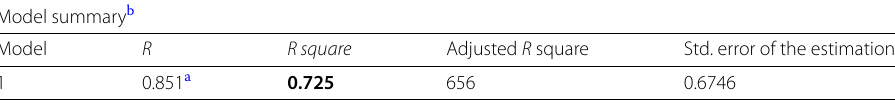
Table 10 Coefficient of determination ( R square) table of the physical and mechanical properties of total porosity-open porosity